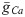
The effect of the lower voltage bound Vlow of oscillations on fres and Zmax constrains the optimal models.a. An example of the change in Z(f) measured in the biological PD neuron for Vlow = -60mV (black line) and Vlow = -70mV (grey line). Inset shows the bounds of voltage clamp inputs in the two cases. b. Shifting Vlow from -60 mV to -70 mV lowers the value of fres measured in the PD neuron significantly, without influencing Zmax (b. Experimental). fres and Zmax values measured in a random subset of optimal model neurons corresponding to low or high g¯Ca values produced the same fres and Zmax values at Vlow = -60mV (black dots), but distinct fres and Zmax values at Vlow = -70mV (low g¯Ca: red dots; high g¯Ca: cyan dots). A subset of optimal models could reproduce the experimental result in which fres shifted to significantly lower values without affecting Zmax. (grey dots). (c)
g¯Ca−V1/2Ca∞h relationship separating out the different groups of models producing different responses to changes in Vlow (colors correspond to b Model panel). Models depicted by grey dots are referred to as intermediate g¯Ca models. (d1-e3) mean voltage-gated ionic currents ICa, IH and ICa+IH and Itotal, shown as a function of voltage for Vlow = -60 mV (d1-d3) and Vlow = -70 mV (e1-e3). Numbers correspond to the location along the g¯Ca−V1/2Ca∞h as shown in c. f. The intermediate g¯Ca models (grey dots) show a distinct g¯Ca−V1/2Ca∞h linear correlation. g. Intermediate g¯Ca models (grey dots) show a distinct and tighter τmCa−τhCa correlation compared to all optimal models (black dots). h. Intermediate g¯Ca models (grey dots) show a strong g¯Ca−g¯H linear correlation that is not observed for all optimal models (black dots).